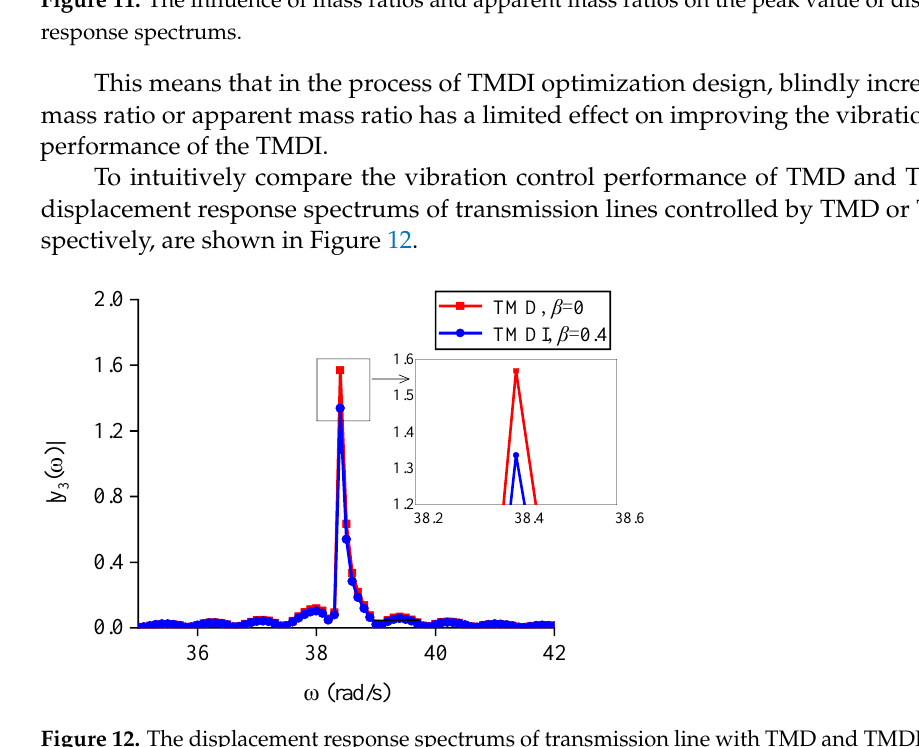
Figure 12. The displacement response spectrums of transmission line with TMD and TMDI ( μ = 0.02).